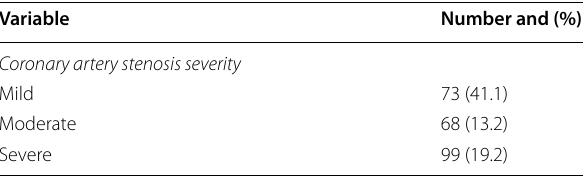
Table 8 Coronary artery stenosis